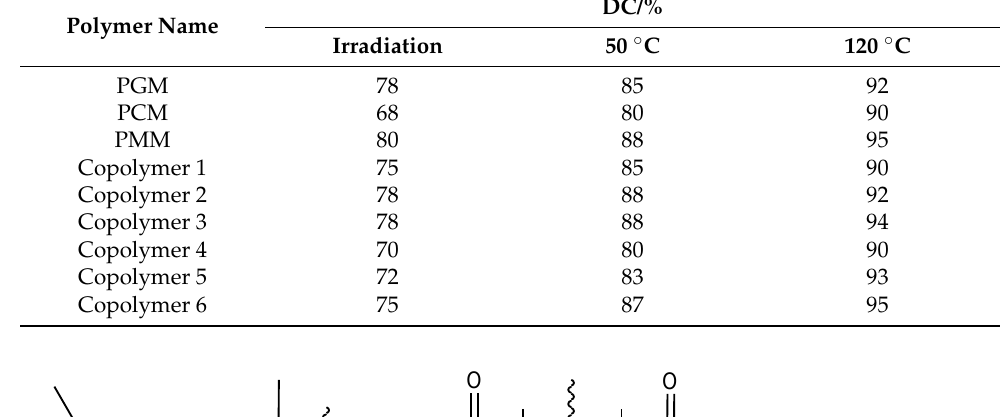
Table 3. Conversion degree (DC) of double bonds.